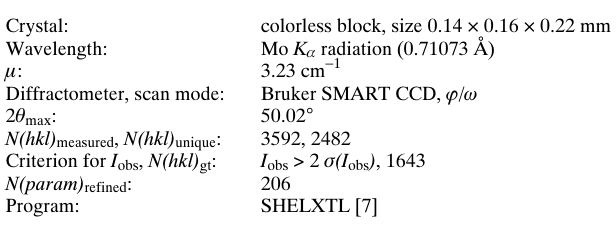
Table 1. Datacollection and handling.